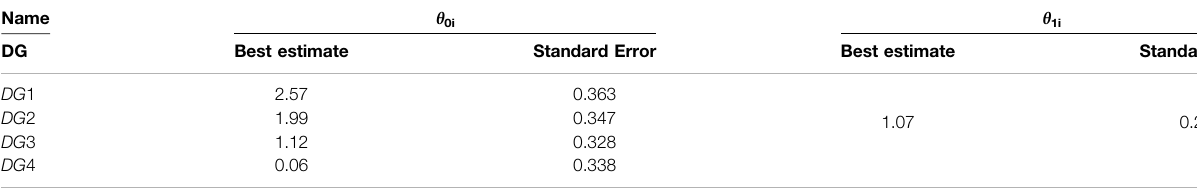
TABLE 3 | Best estimate and standard error of the two regression coef fi cients for the fi tted parametric model.